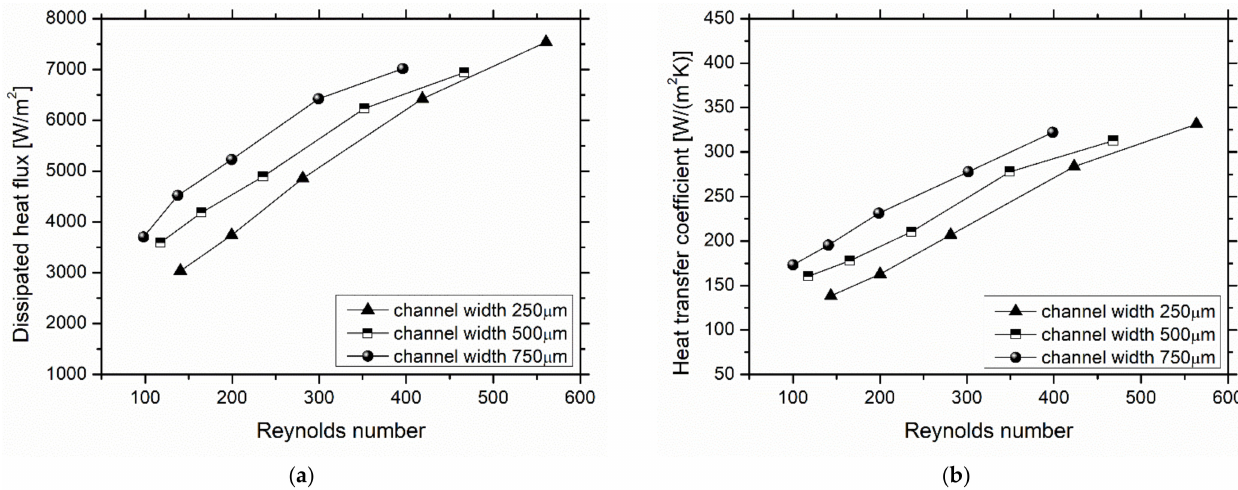
Figure 2. Effect of the channel width on: ( a ) dissipated heat flux and ( b ) heat transfer coefficient for single-phase water flow in the heat